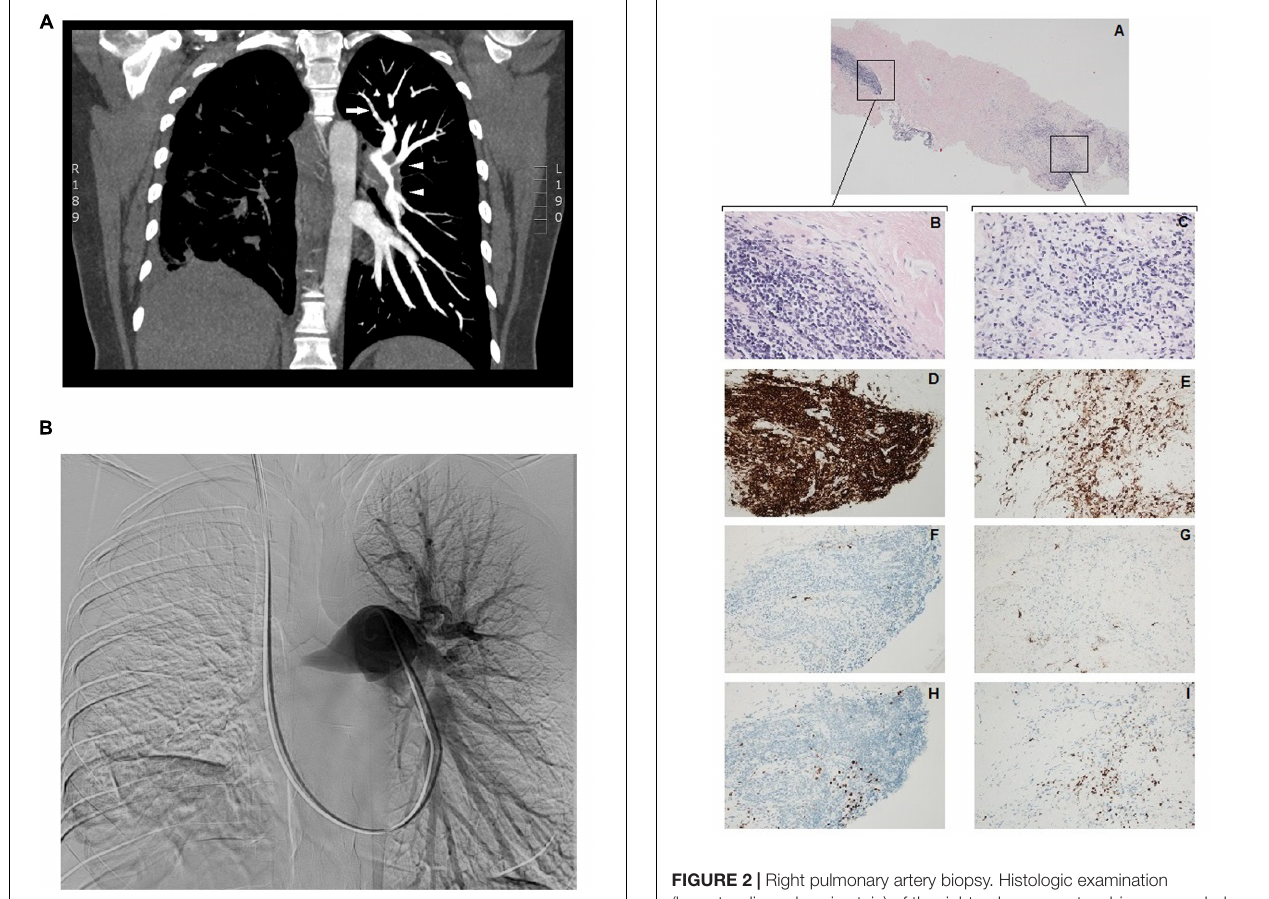
FIGURE 1 | Pulmonary artery occlusion. CT pulmonary angiography (A) showed near-complete occlusion of the right pulmonary artery without any flow and elevated right hemidiaphragm. There was severe thickening of the left lobar pulmonary arteries and short-segment stenosis (white triangles) and wall irregularities (white arrow) in the left lobar and segmental pulmonary arteries. Similar findings were observed during digital subtraction angiography (B) .